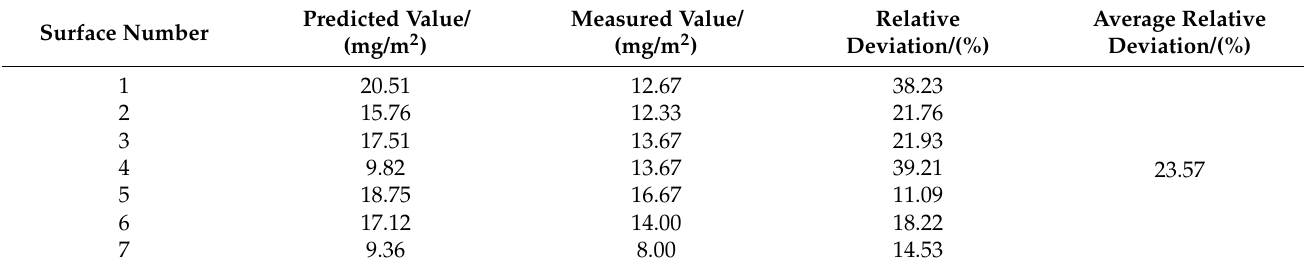
Figure 4. Prediction of oil contamination concentrations of each surface. Table 2. Comparison of predicted and measured values.